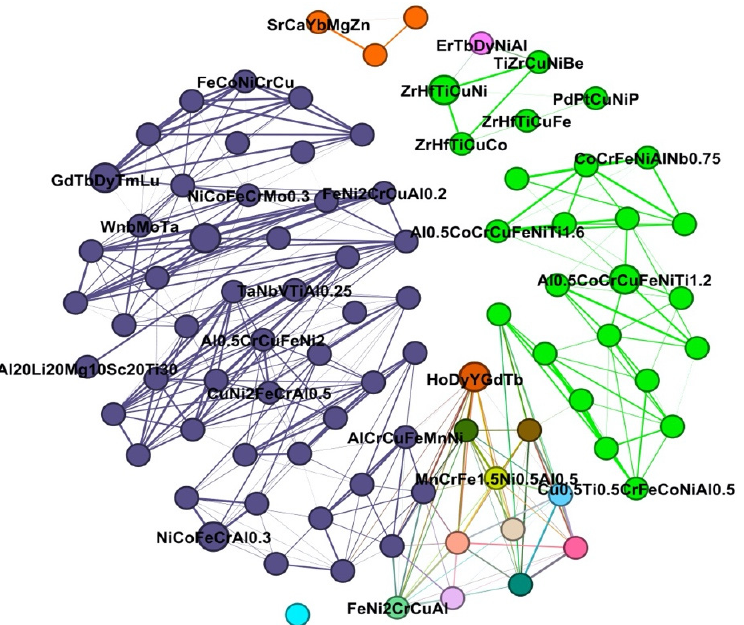
Figure 2. A portion of the HEA interaction network with Fruchterman Reingold layout. Nodes with a larger circle have more neighbors, which indicates a stronger relationship.